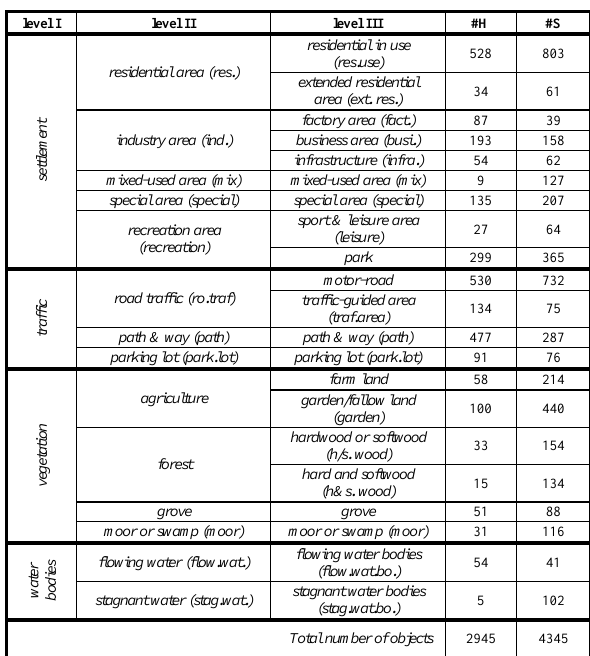
Table 2: Overview of the results of hierarchical land use classification achieved by LuNet-lite-JO-T, LuNet-lite- JO-MS and LuNet-lite-JO-ENS for Hameln and Schleswig. 𝐹1̅̅̅̅ : mean F1 score [%], OA: Overall Accuracy [%]. Best scores are shown in bold